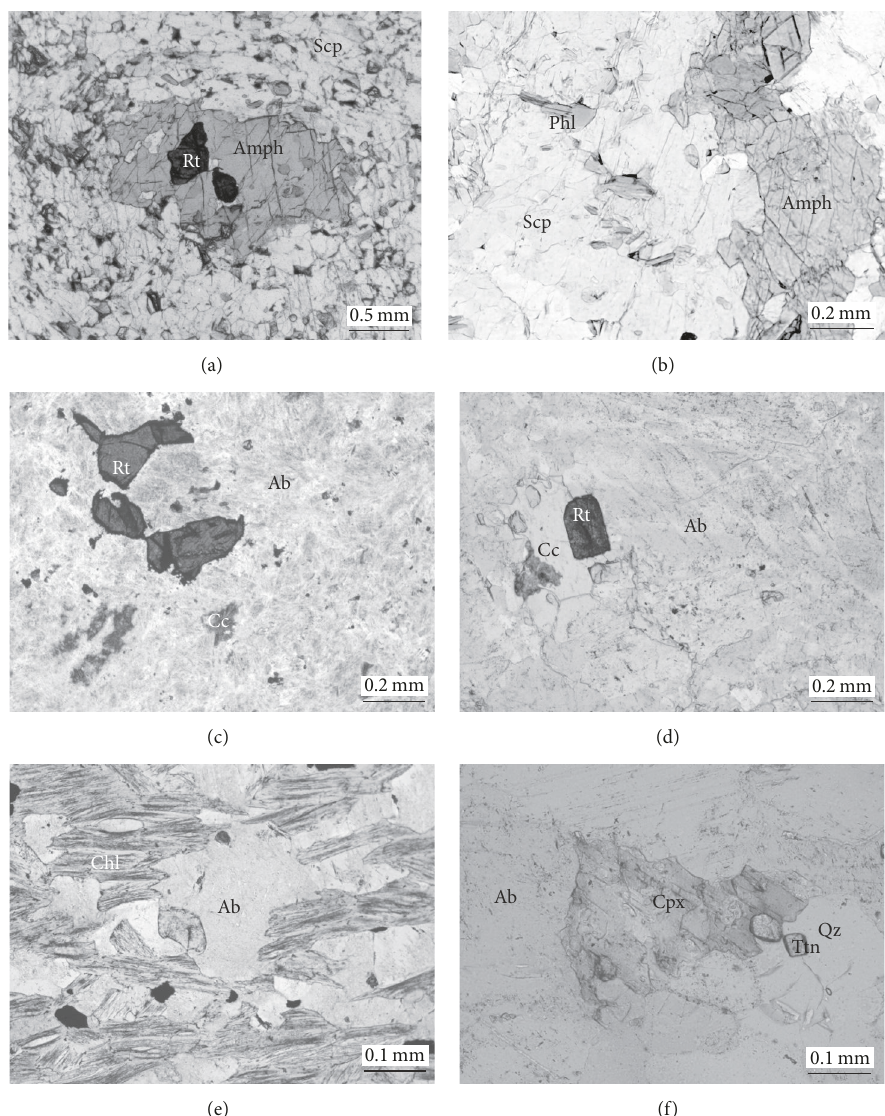
Figure 4: Photomicrographs of representative petrography from metasomatised rocks (mineral abbreviations after Whitney and Evans [36]). (a) Scapolite metagabbro dominated by scapolite and amphibole with accessory rutile. Locality Ødeg˚arden Verk, sample 2Ø91.45. (b) Phlogopite-bearing scapolite metagabbro. Locality Langøy, sample AE46. (c) Rutile-bearing albitite from veining in an amphibolite. Locality Ringsjø, sample AE10A. (d) Calcite-rich albitite (albitite vein deposit) with rutile. Locality Langøy, sample AE93. (e) Banded albitite felsites with the foliation outlined by chlorite. Locality Langøy, sample AE87. (f) Clinopyroxene-bearing albitite with quartz and titanite. Locality Storkollen, sample